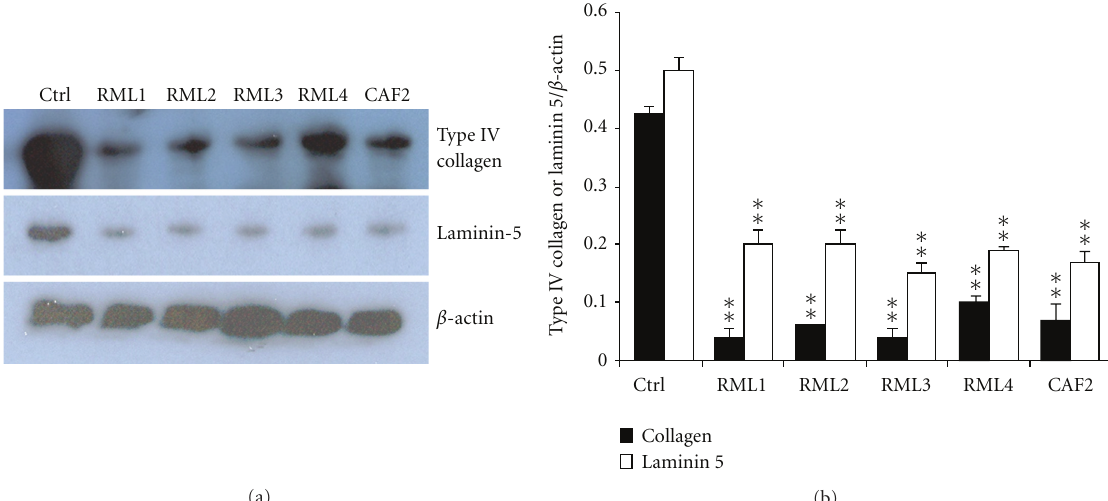
Figure 7: C. albicans downregulated basement membrane protein production. Total proteins were extracted from the infected EHOMs and analyzed by western blotting for the presence of laminin 5 and type IV collagen. (a) Representative gel of three separate experiments. Unstimulated tissue was used as a control (Ctrl). Protein production modulation was determined by band scanning using public domain NIH Image software. (b) Histograms are the means + SD ( n = 4). Statistical di ff erences were found by comparing the values obtained from the infected and noninfected tissues. ∗∗ P < 0 .